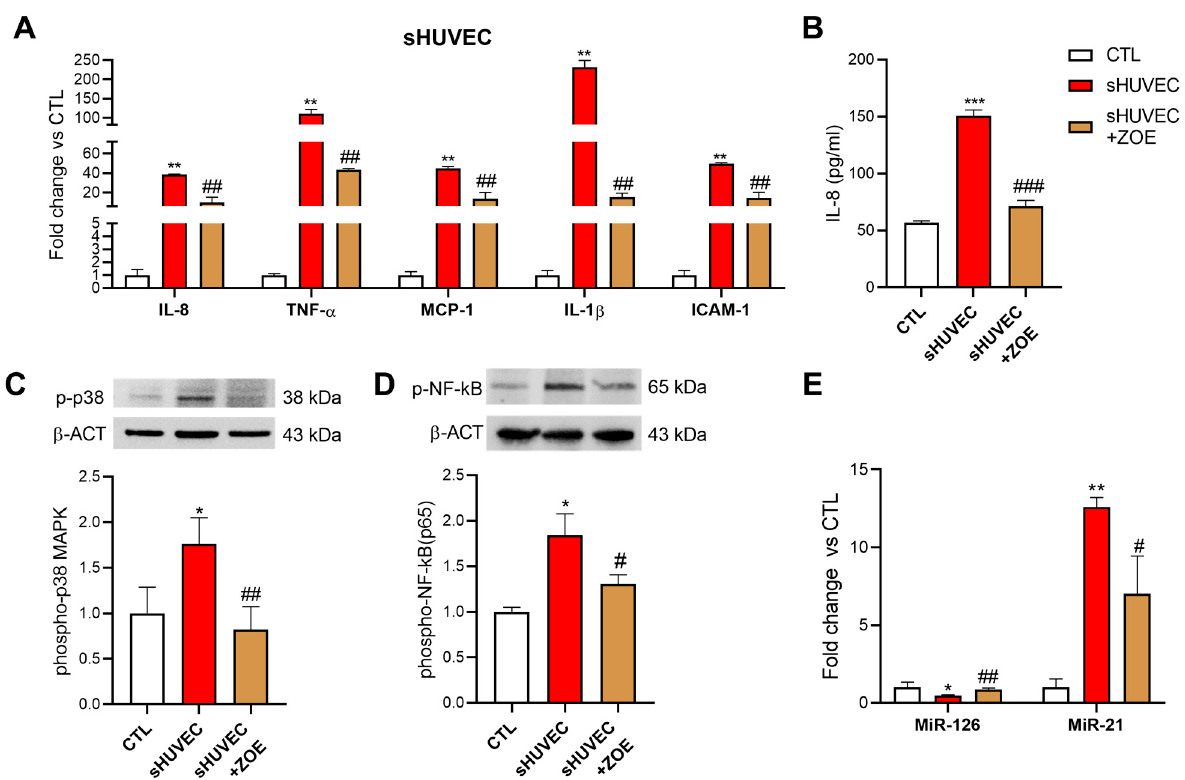
Figure 5. ZOE senomorphic effect on sHUVEC. Relative mRNA expression of IL-1 β , TNF- α , MCP-1, IL-8, and ICAM-1 ( A ), concentration (pg/mL) of IL-8 in the culture medium ( B ), representative western blot analysis showing phospho-p38 MAPK ( C ) and phospho-NF-kB(p65) ( D ) expression level in yHUVEC, expression levels of miR-21 and miR-126 ( E ). β -actin and α -tubulin were used as a control. The bands were quantified by ImageJ. All data are reported as fold change vs. yHUVEC (CTL). The results are expressed as mean ± SD from three independent biological replicates. Asterisks (*) indicate significance versus CTL; (#) indicates significance versus untreated sHUVEC; one symbol, p < 0.05; two symbols, p < 0.01; three symbols, p < 0.001.